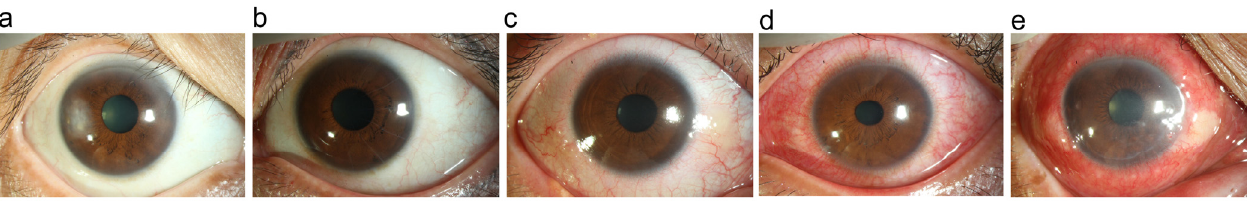
Figure 1. Grade of bulbar conjunctival injection severity based on the Cornea and Contact Lens Re- search Unit scal. ( a ): Grade 0, ( b ): Grade 1, ( c ): Grade 2, ( d ): Grade 3, ( e ): Grade